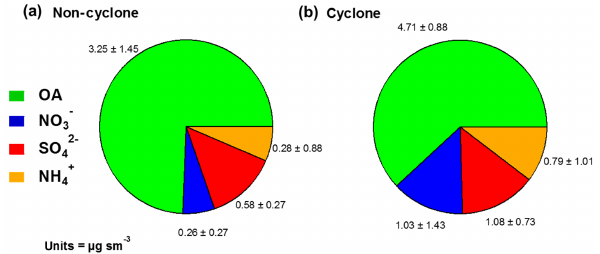
Figure 8. Average chemical composition of mAMS species in all regions during (a) non-cyclone and (b) cyclone events. Chlo- ride (Cl − ), not shown, was below the instrument detection